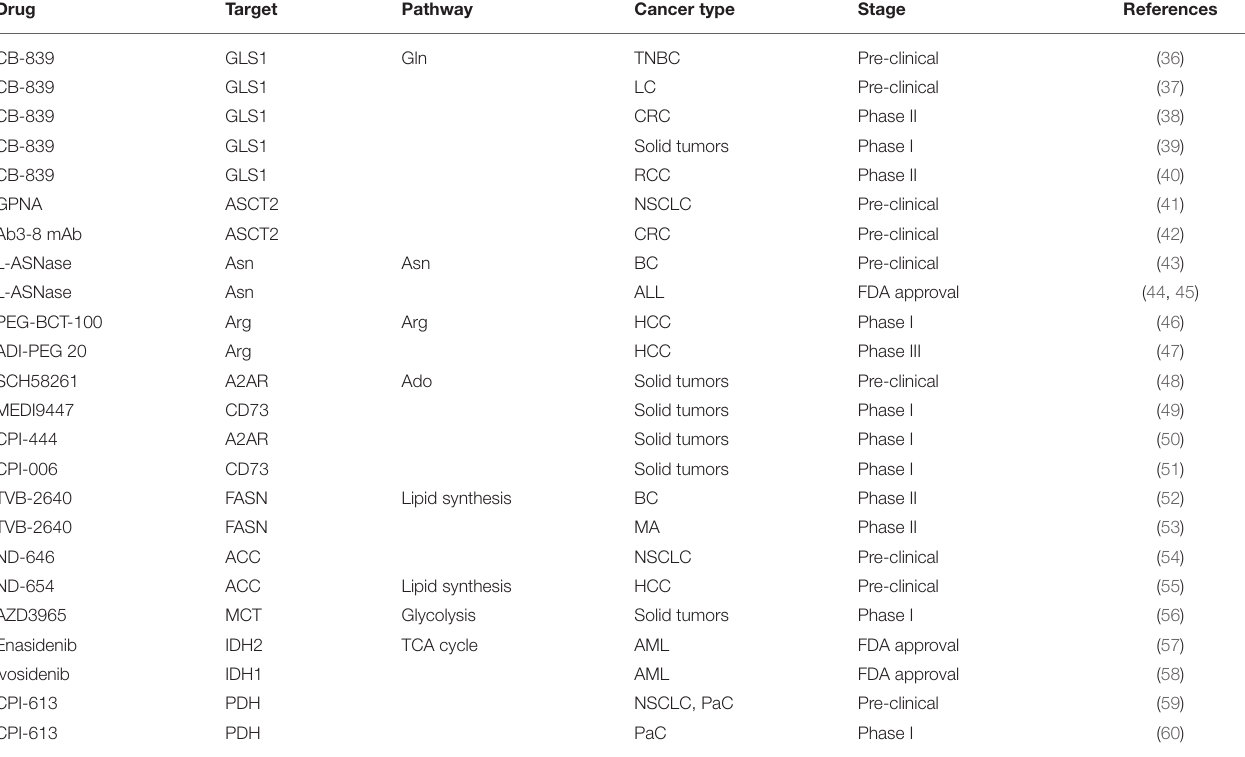
TABLE 1 | Developing treatments for targeting cancer metabolism.